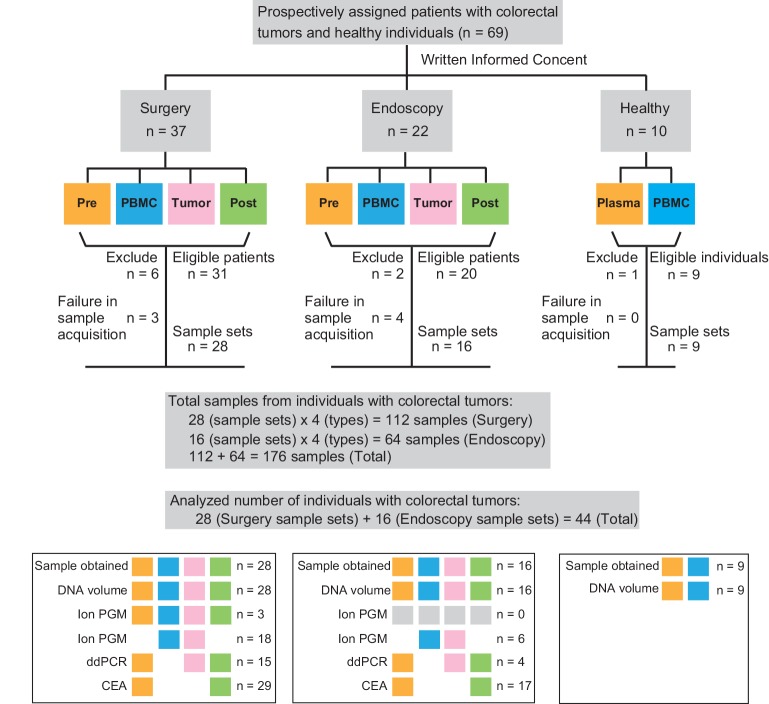
Sample collection diagram.All samples were collected prospectively. Samples were collected from the following three groups; Surgery, Endoscopy, and Healthy Volunteers. Surgery and Endoscopy groups contain Pre (pre-operative plasma), PBMCs, Tumor, and Post (post-operative plasma) samples. Samples from patients showing Stage IV disease, insufficient sample size, or insufficient extracted DNA amount were excluded from the study (detailed information in text). The color of each box indicates which procedures were used for analysis each type of sample.